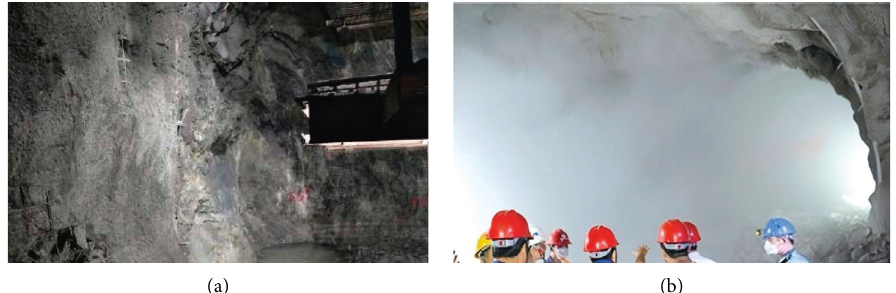
Figure 1: Deficiencies of conventional blasting technology. (a) Over and underexcavation. (b) Dust in tunnel